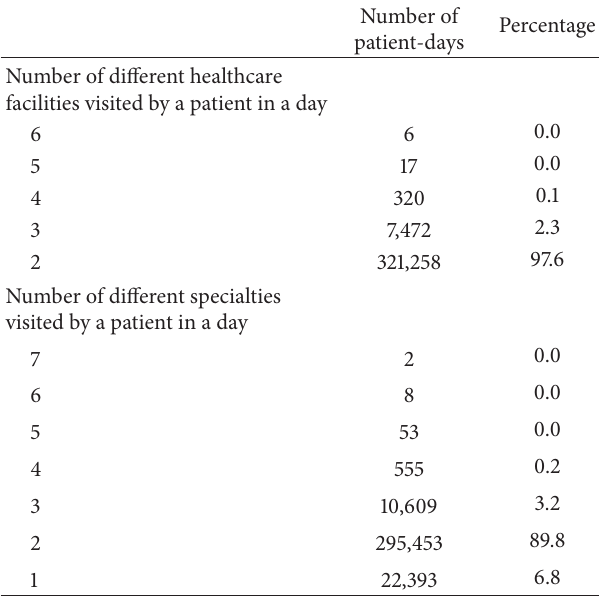
Table 1: Distribution of a patient’s visits to different healthcare facilities within one day in the 1,000,000-person cohort in 2010, stratified by numbers of different healthcare facilities and specialties in a